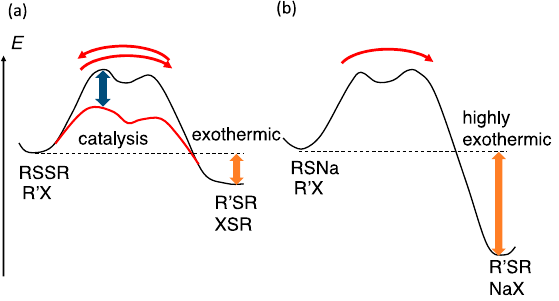
Figure 3. ( a ) Chemical equilibrium of rhodium-catalyzed reactions using disulfides and a cosubstrate; ( b ) highly exothermic irreversible reaction using metal thiolates. ( b ) highly exothermic irreversible reaction using metal